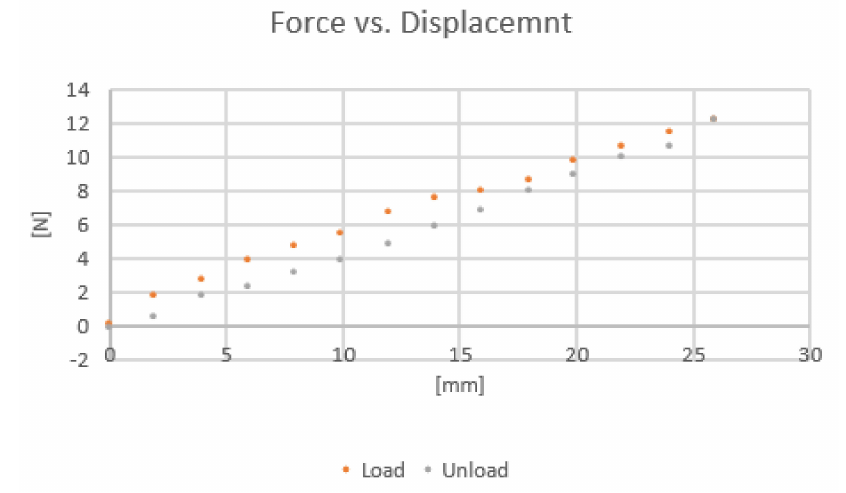
Figure 10. SMA spring force vs. displacement